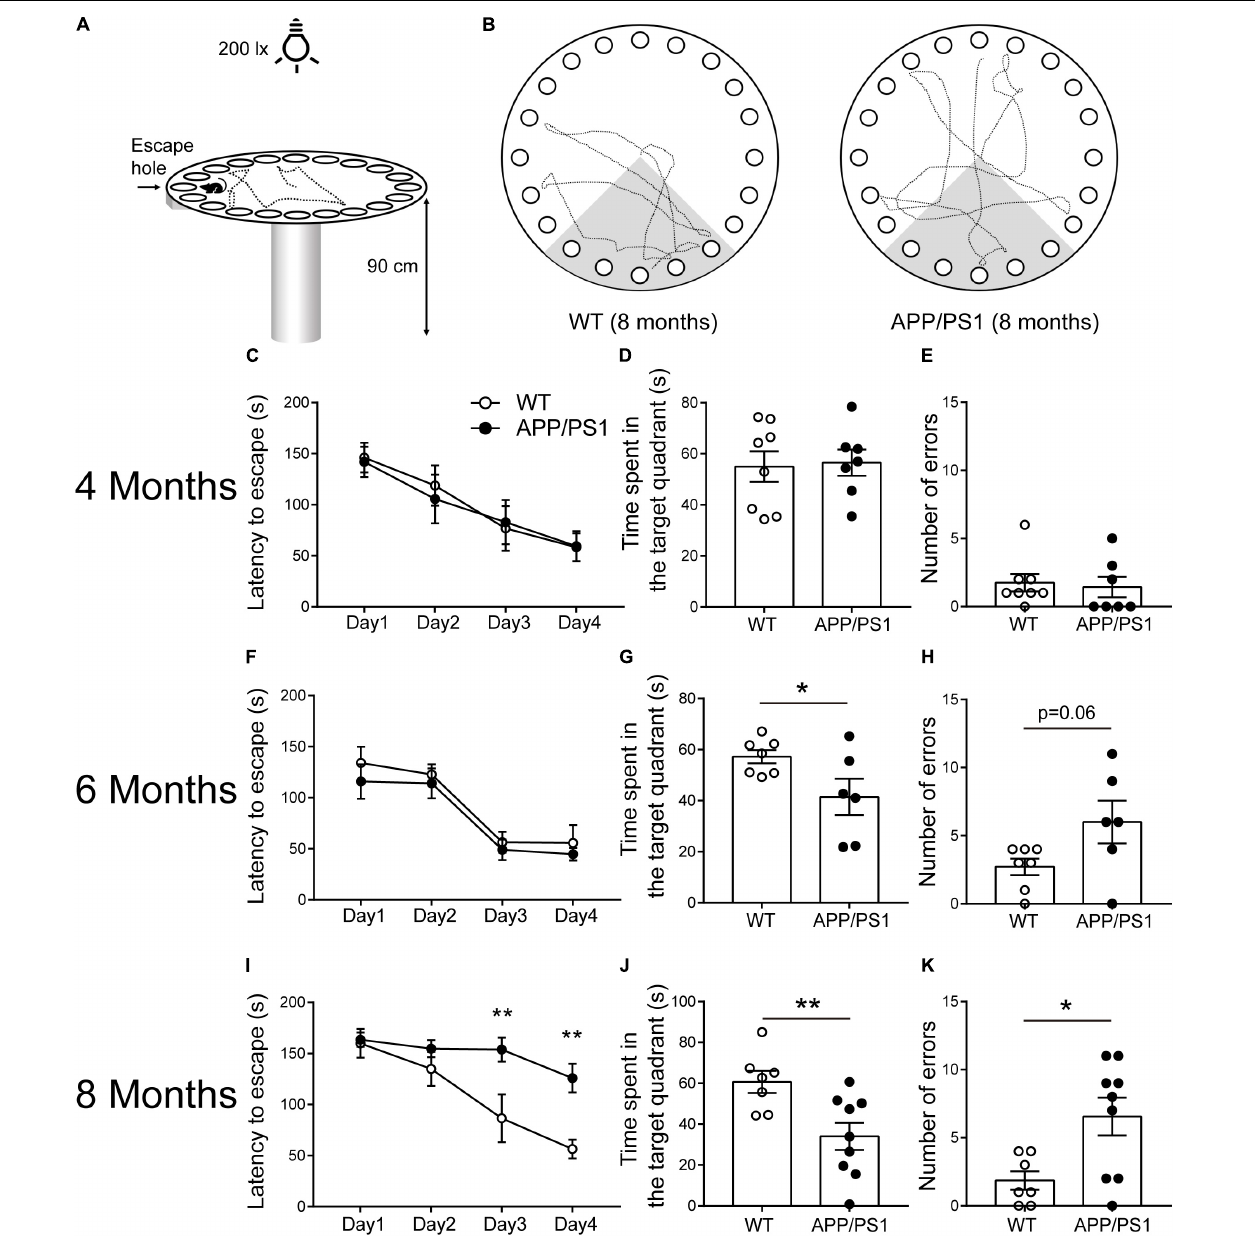
FIGURE 2 | Barnes maze performance for 4-, 6-, and 8-months-old WT and APP/PS1 mice ( n = 6–9/group). (A) The illustration shows our Barnes maze installation. (B) Example of trajectories of 8-month-old WT and APP/PS1 mice during the probe session. (C–E) In 4-month-old WT and APP/PS1 mice, no statistically significant differences were observed in the indicators (latency to escape, time spent in the quadrant, and the number of errors) of the Barnes maze. (F–H) In 6-month-old mice, the time APP/PS1 mice spent in the target quadrant is decreased compared with WT mice (* p < 0.05, unpaired t -test), but no differences were observed in the escape latency and the number of errors. (I–K) In 8-month-old APP/PS mice, the latency to escape was decreased in both day 3 and 4 of the training phase (interaction: * p < 0.05; at Day 3 or Day 4, ** p < 0.01, two-way ANOVA followed by Bonferroni’s post hoc test), the time spent in the target quadrant was reduced (** p < 0.01, unpaired t -test), and the number of errors was increased compared with WT mice (* p < 0.05, unpaired t -test).